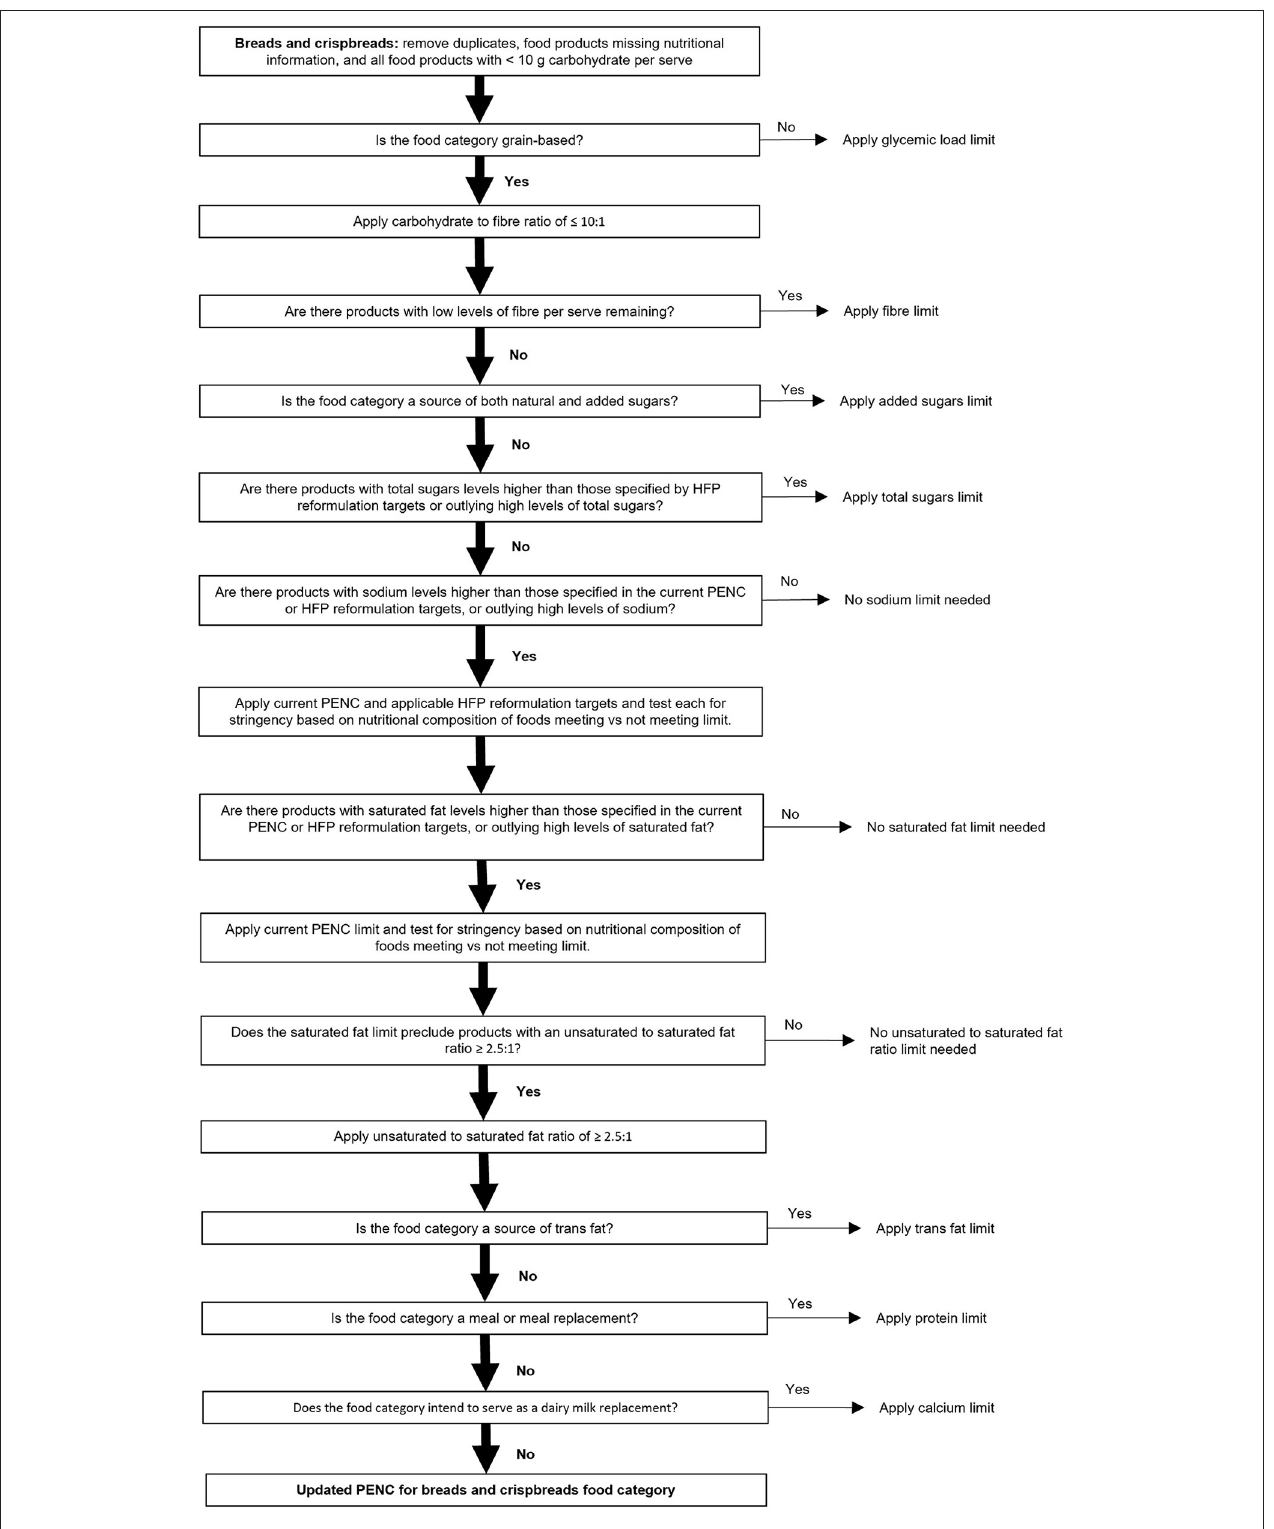
FIGURE 3 | Overview of the specific step-wise modeling strategy for the ‘breads and crispbreads’ food category. Where a yes/no option existed, only the selection (yes/no; vertical path and shown by a solid black arrow) followed for breads and crispbreads has been described in detail.